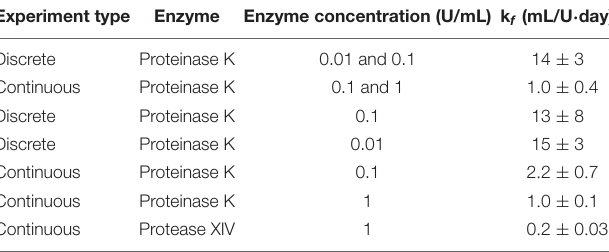
TABLE 1 | Modified first order rate constant determined from weighted least squares analysis and standard deviation for k f calculated using Monte Carlo studies for 12 h WA silk sponges immersed in varying concentrations of Proteinase K and Protease